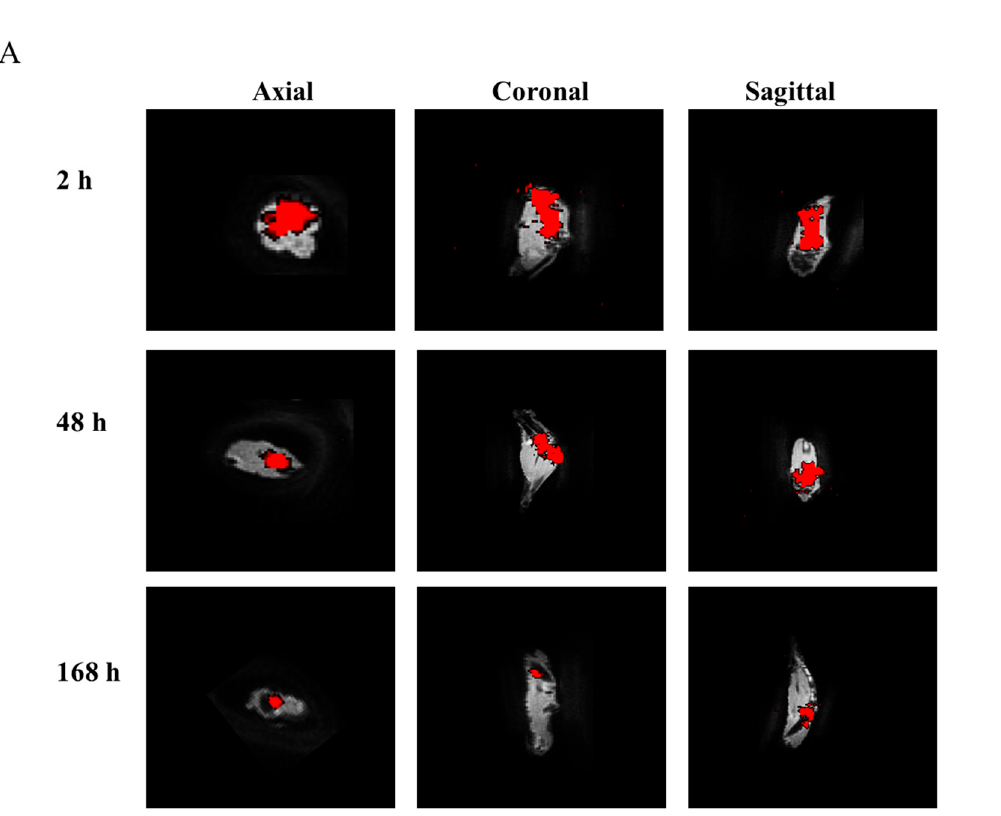
Figure 7. Representative images of PLGA-PEG-TFA NPs in ex vivo. ( A ) Ex vivo 19 F-MRI images in axial, coronal and sagittal view of the right knee. The image was taken at 2, 48, and 168 h post-NP injection. Red shows the signal of TFA present on the surface of PLGA-PEG-TFA NPs. ( B ) Histological staining images. From left to right healthy knee (negative control), osteoarthritis (OA) knee without NPs treatment (positive control), representative pictures of OA knee treated with PLGA-PEG-TFA NPs. ( B1 ) Hematoxylin/Eosin and F4/80 staining, macrophages are indicated with the black circle. ( B2 ) Histological staining with Safranin-O fast green. 4. Conclusions We designed and developed a new intrinsic co-polymer, namely PLGA-PEG-TFA, that allowed us to trace the NPs by 19 F-MRIIt was successfully visualized and traced in